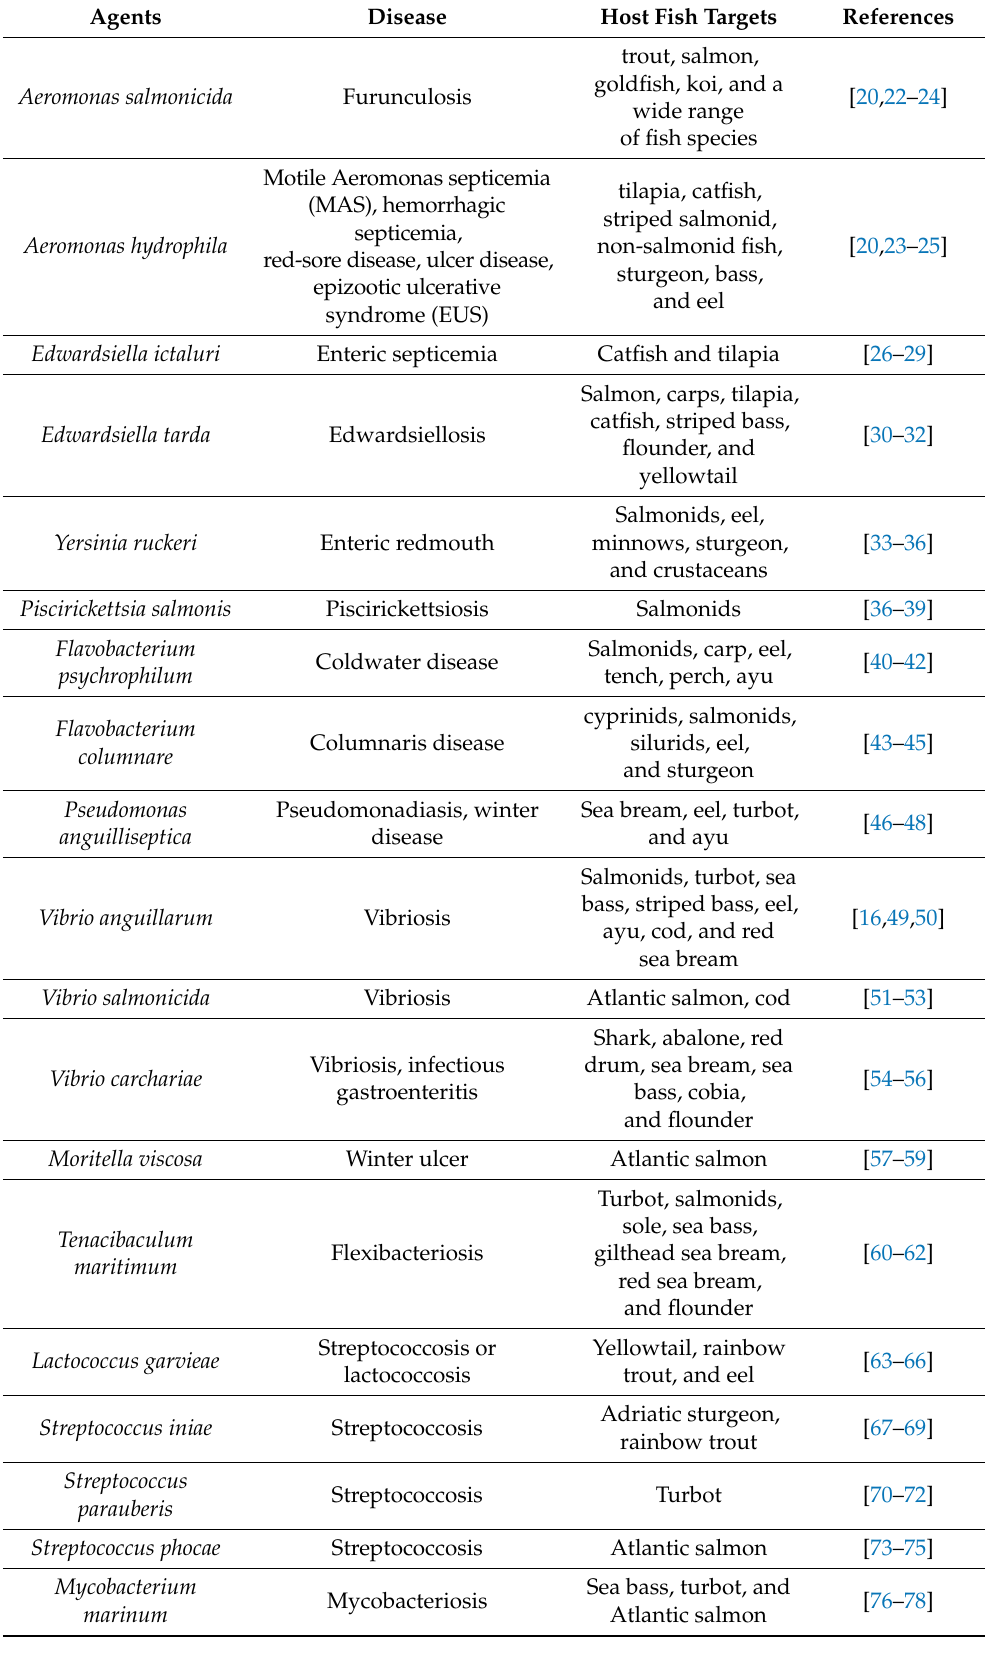
Table 1. Bacterial Pathogens of